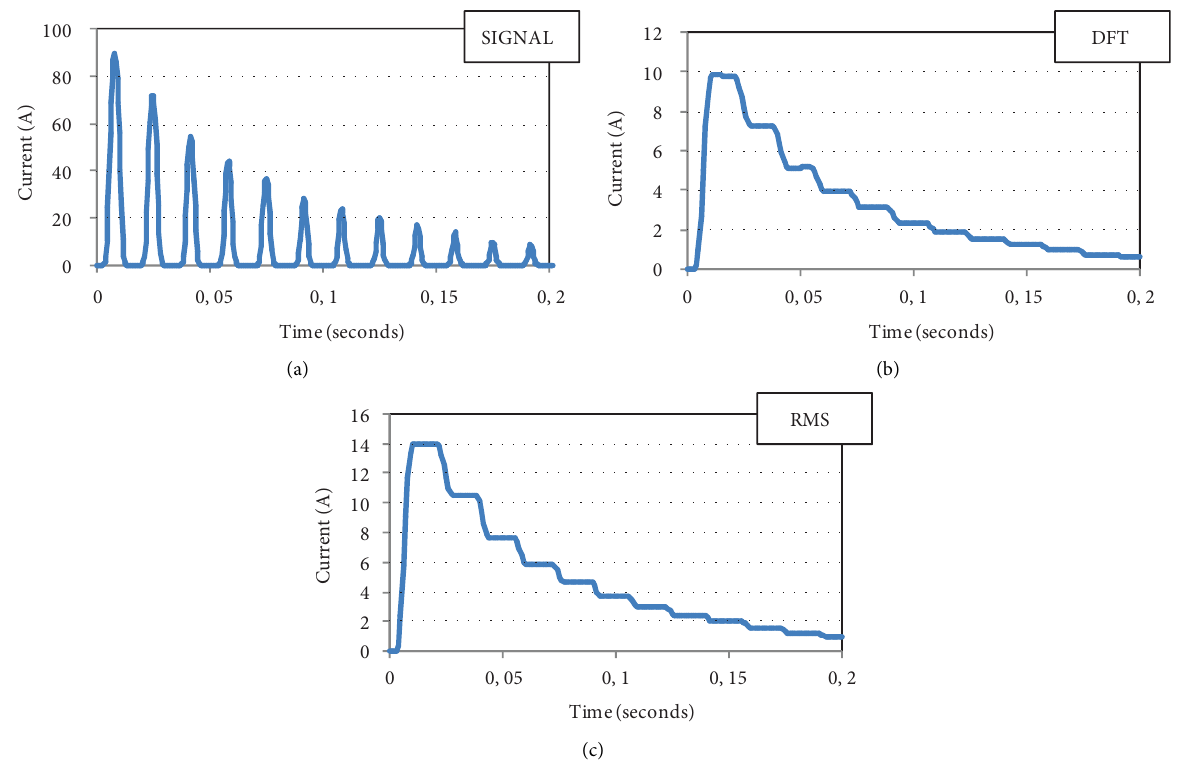
Figure 1: Illustrative example about the dynamics of NOCF: (a) waveform of TMIC taken as an example; (b) result of I DFT algorithm; (c) result of I MOD , computed by RMS algorithm.